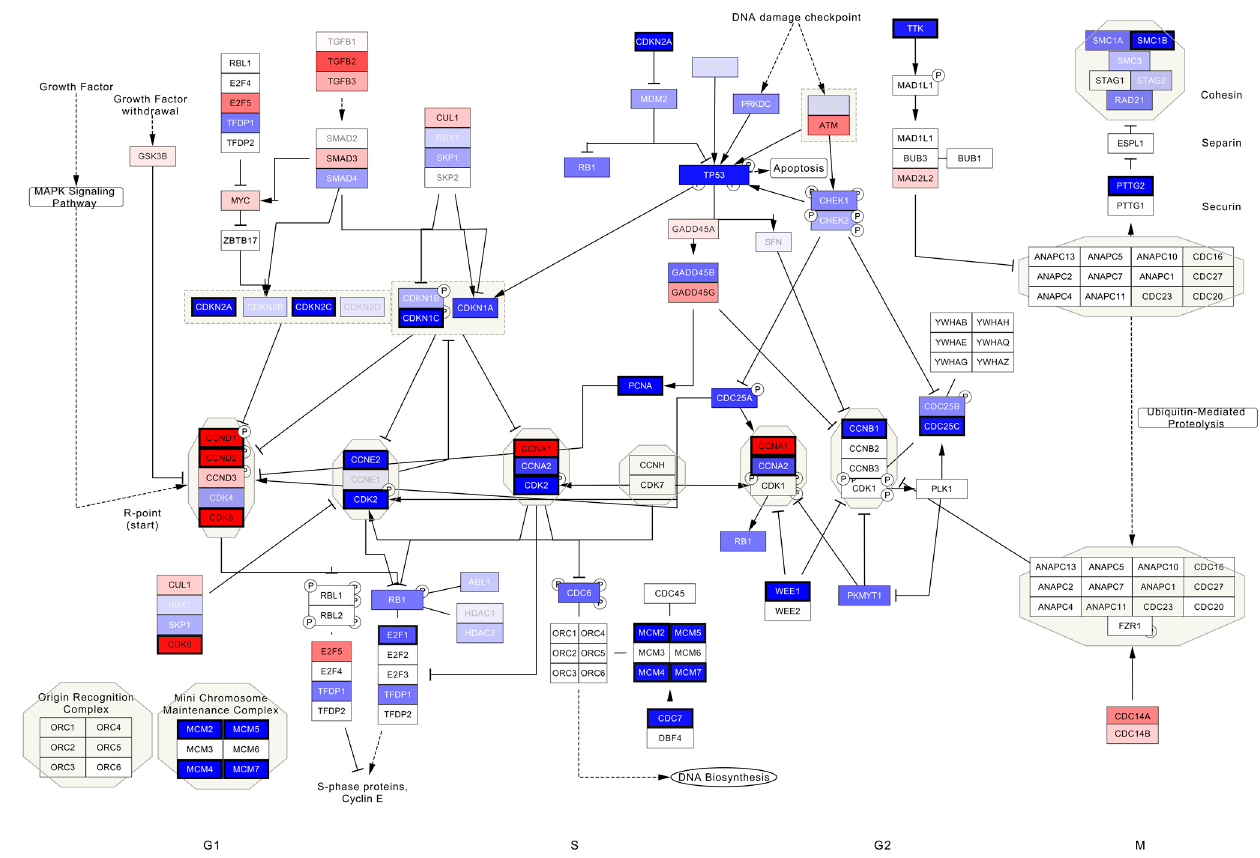
Figure 3. The human cell cycle pathway (WP179). The labels are colored according to the direction of the change in expression. Genes with a higher expression of TP53mut in comparison to HPV+ VSCCs are colored red. A thicker black border marks significantly (FDR ≤ 0.1) differentially expressed genes.